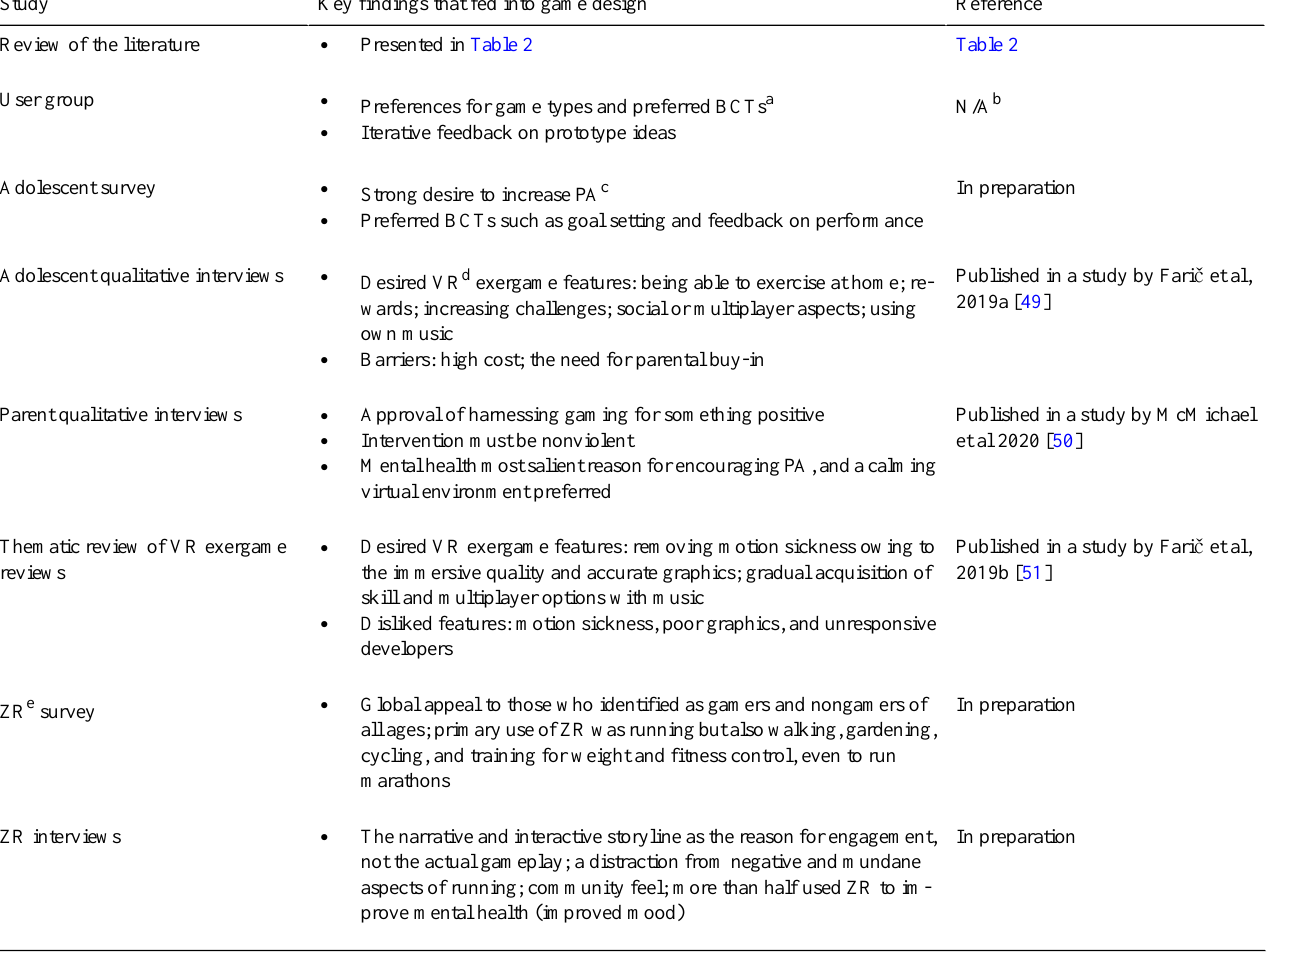
Table 3. Key features of research fed into the game